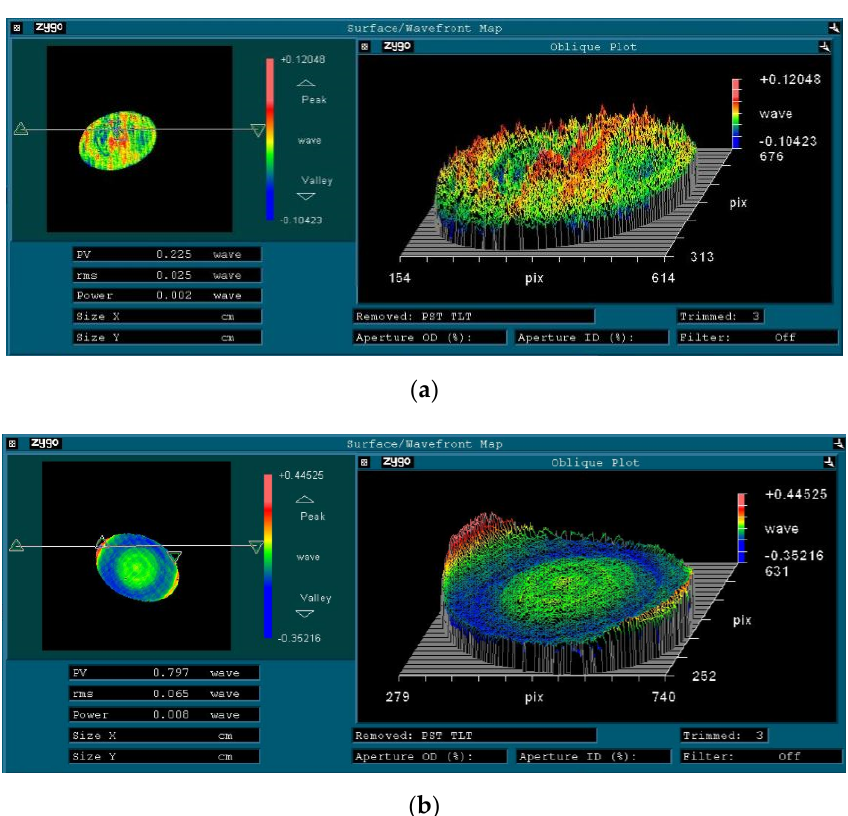
Figure 9. Surface profile test results; ( a ) Visible light mirror; ( b ) Infrared mirror. The results of the surface roughness test of the visible light mirror (before plating the reflection film) are shown in Table 3. A total of 16 subregions were measured. They showed that the surface roughness of the visible light mirror was greater than 3 nm. Table 3. Results of mirror surface roughness/nm.